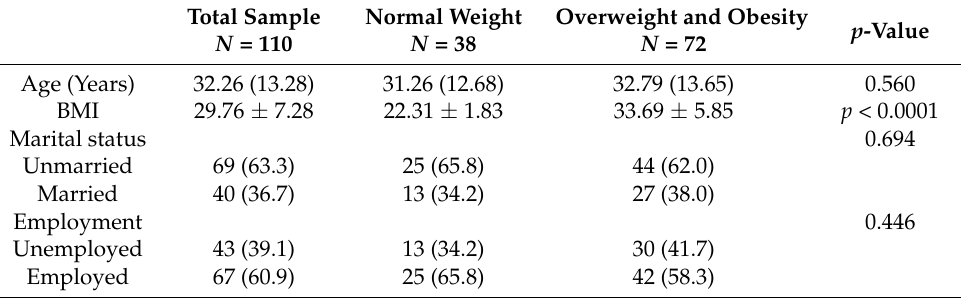
Table 1. Anthropometric and sociodemographic characteristics of the study